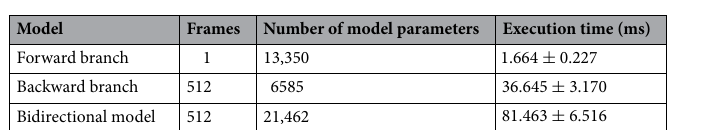
Table 2. Timing results of the two Split BiGRU branches and a baseline BiGRU.